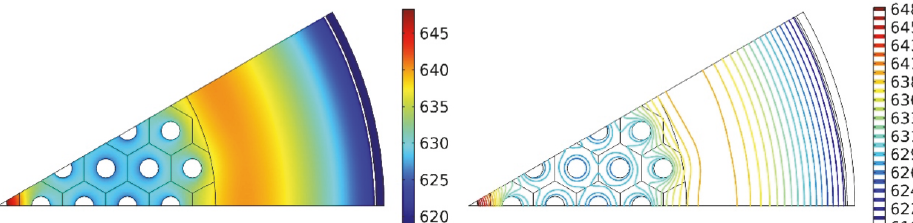
Figure 12: The cross-sectional view of temperature field (left) and isotherms (right) in the solid region near the outlet (z=1.0m) (unit: ∘ C).